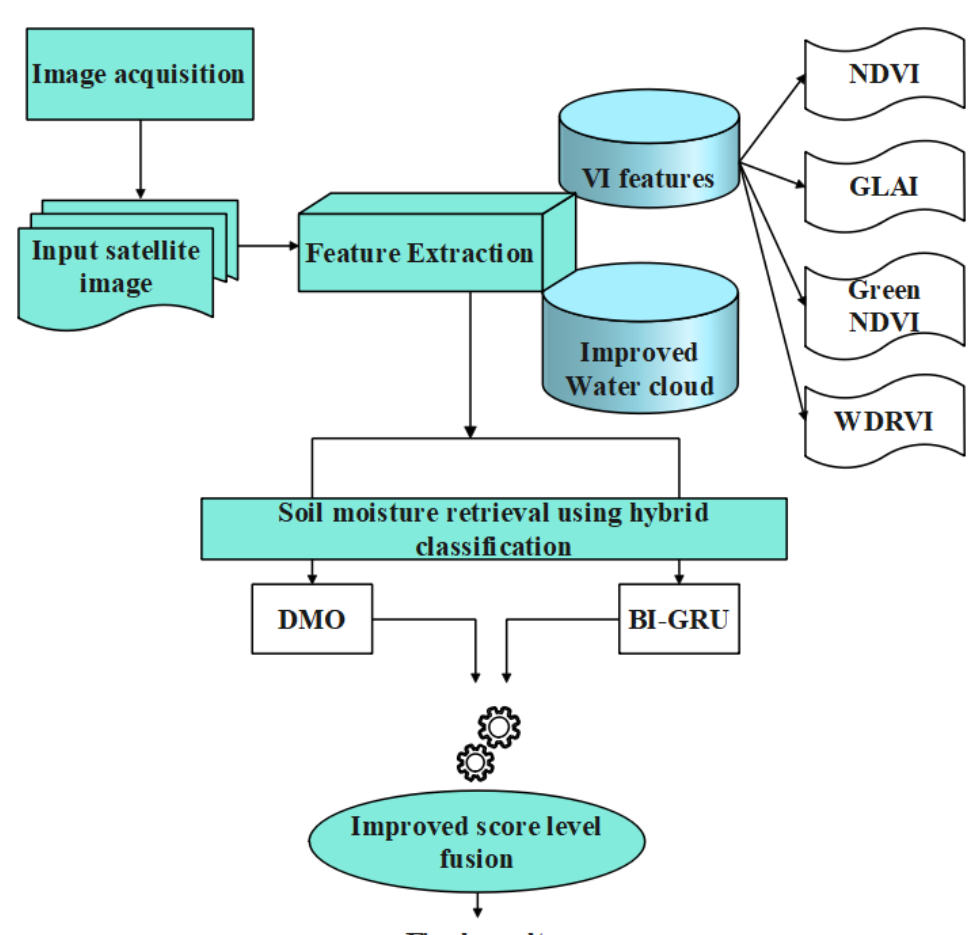
Figure 1. Diagrammatic representation of Soil Moisture Retrieval model.